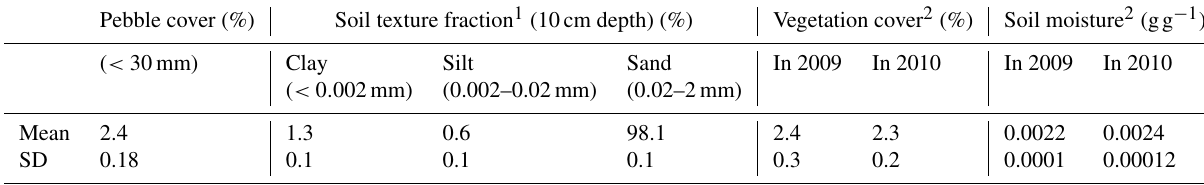
Table 1. Land surface and soil size characteristics in the study area.